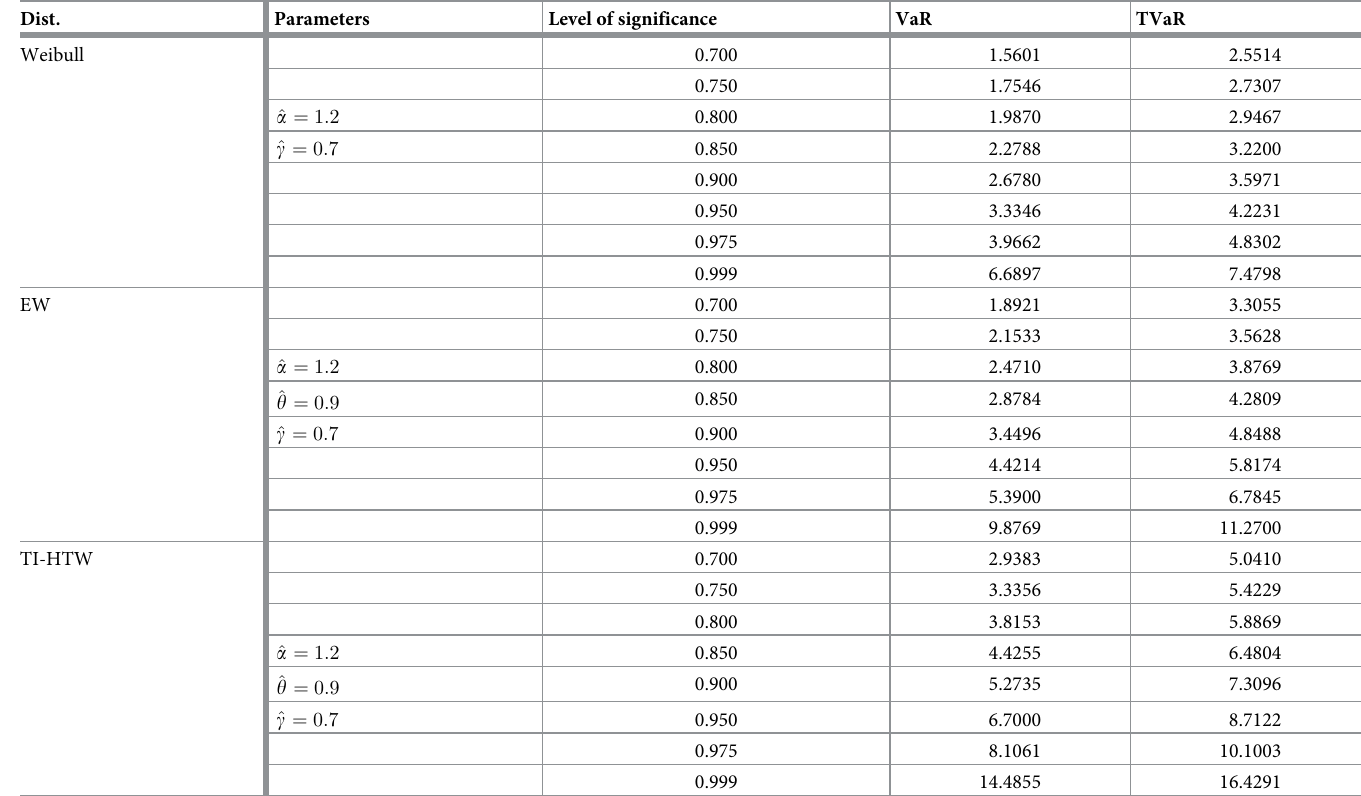
Table 5. Simulation results for VaR and TVaR of the Weibull, EW and TI-HLW distributions.